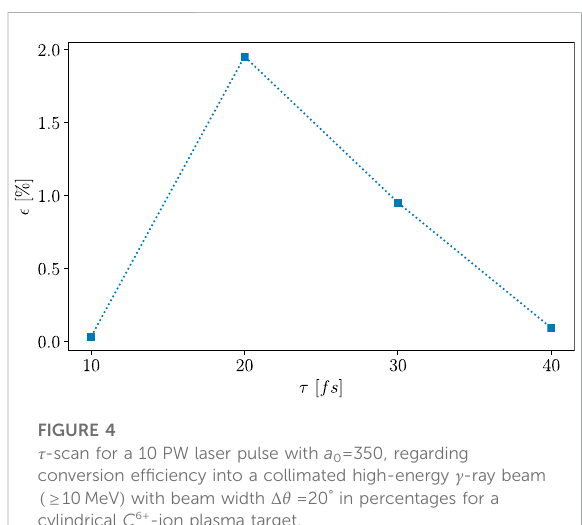
0 =350, regarding